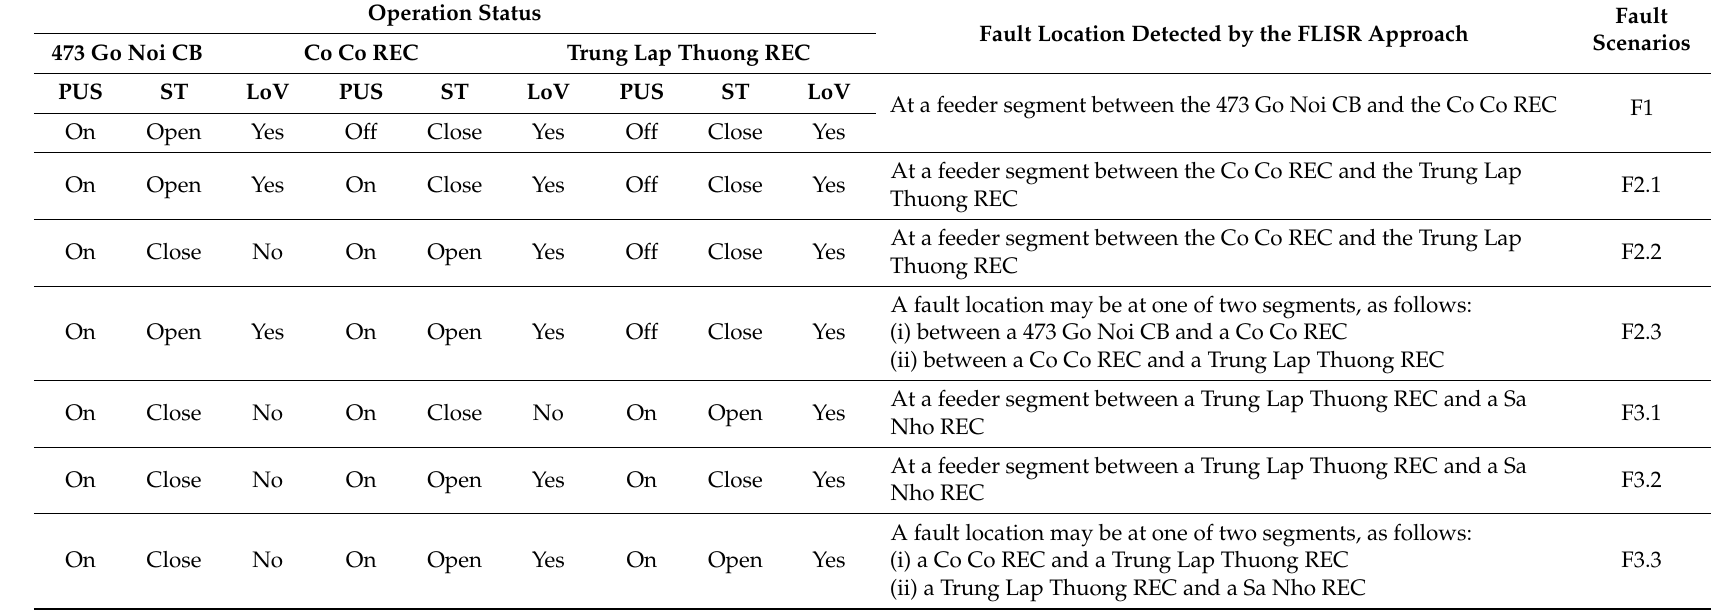
Table 21. The operation status of OC relays and reclosers for all seven different simulation scenarios. Operation